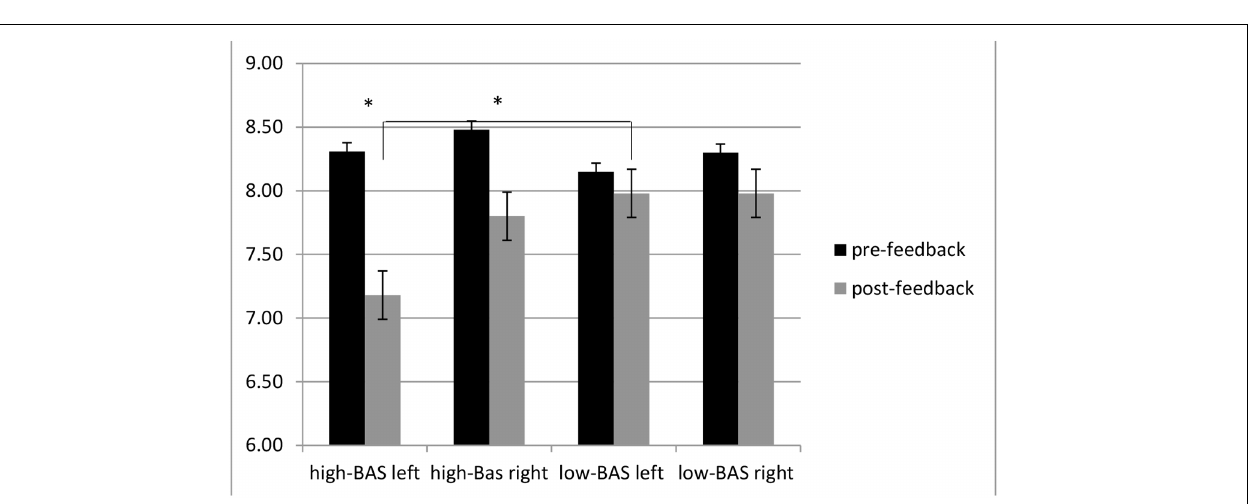
Figure 8 . Indeed BAS increased values explained alpha reduction (brain activation) within the left PFC; similarly BAS increased values explained O2Hb increasing within the left